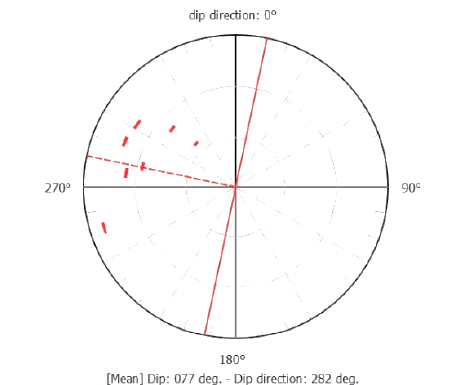
Figure 9. Stereographic projection of structural planes, detected by applying 700 inliers in